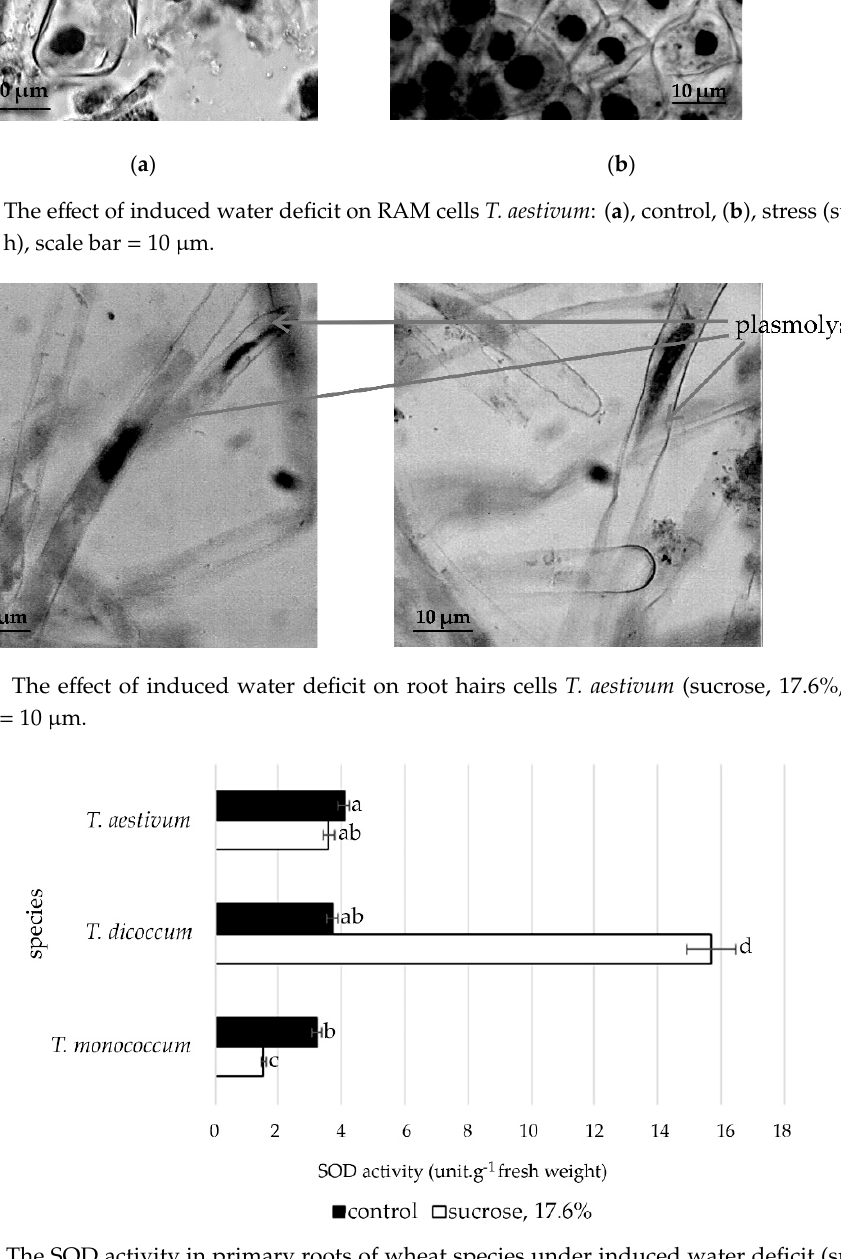
Figure 7. The SOD activity in primary roots of wheat species under induced water deficit (sucrose,